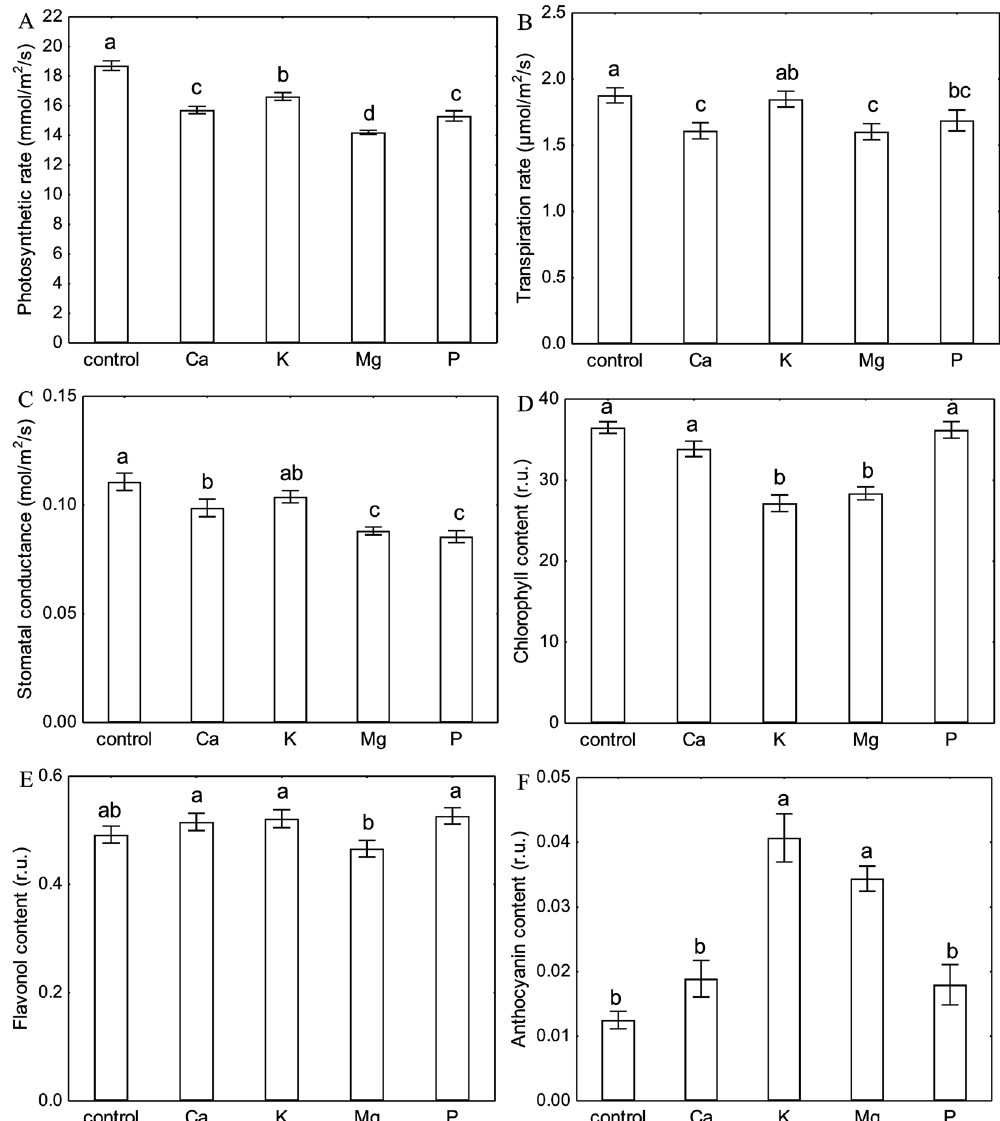
Figure 4. Changes in photosynthetic ( A ) and transpiration ( B ) rate, stomatal conductance ( C ) and chlorophyll ( D ), flavonol ( E ) and anthocyanin ( F ) content in leaves of Zea mays L. under different macronutrient deprivation. Presented values are means ± SE (n = 80, except pigments content, where n = 55). Means followed by the same letter in a single graph are not significantly different from each other using the LSD test (P <